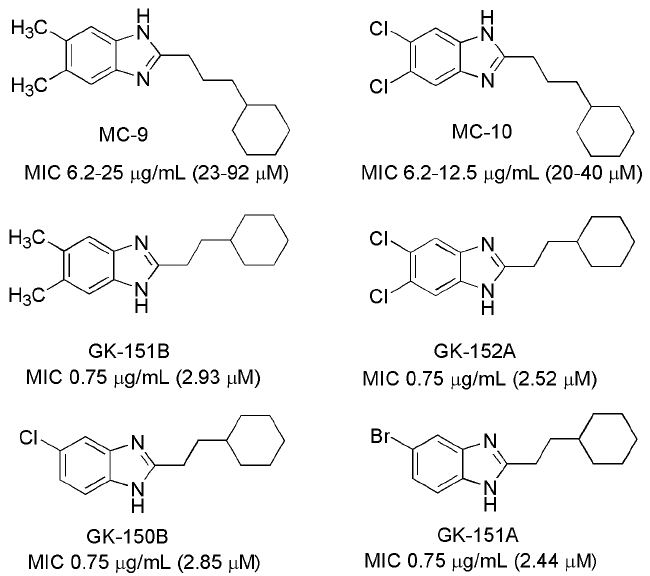
Figure 2. Structure and tuberculostatic activity of some benzimidazole derivatives.